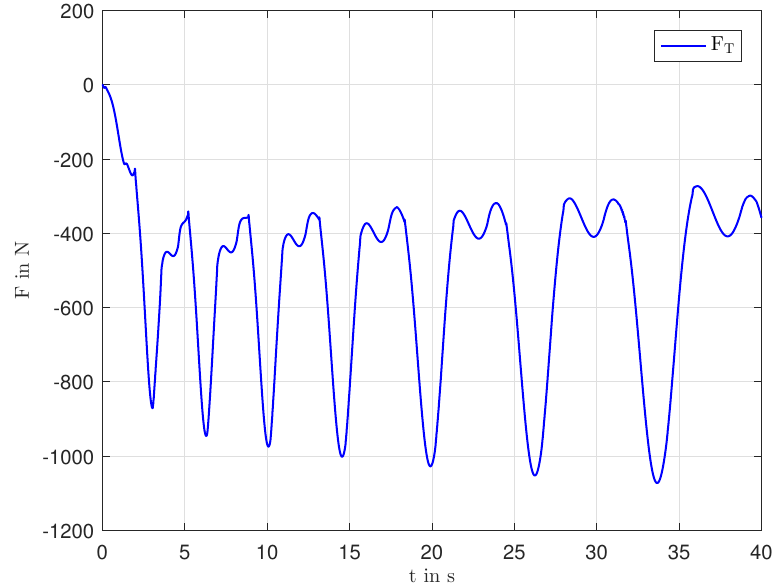
Figure 9. Tether force from the